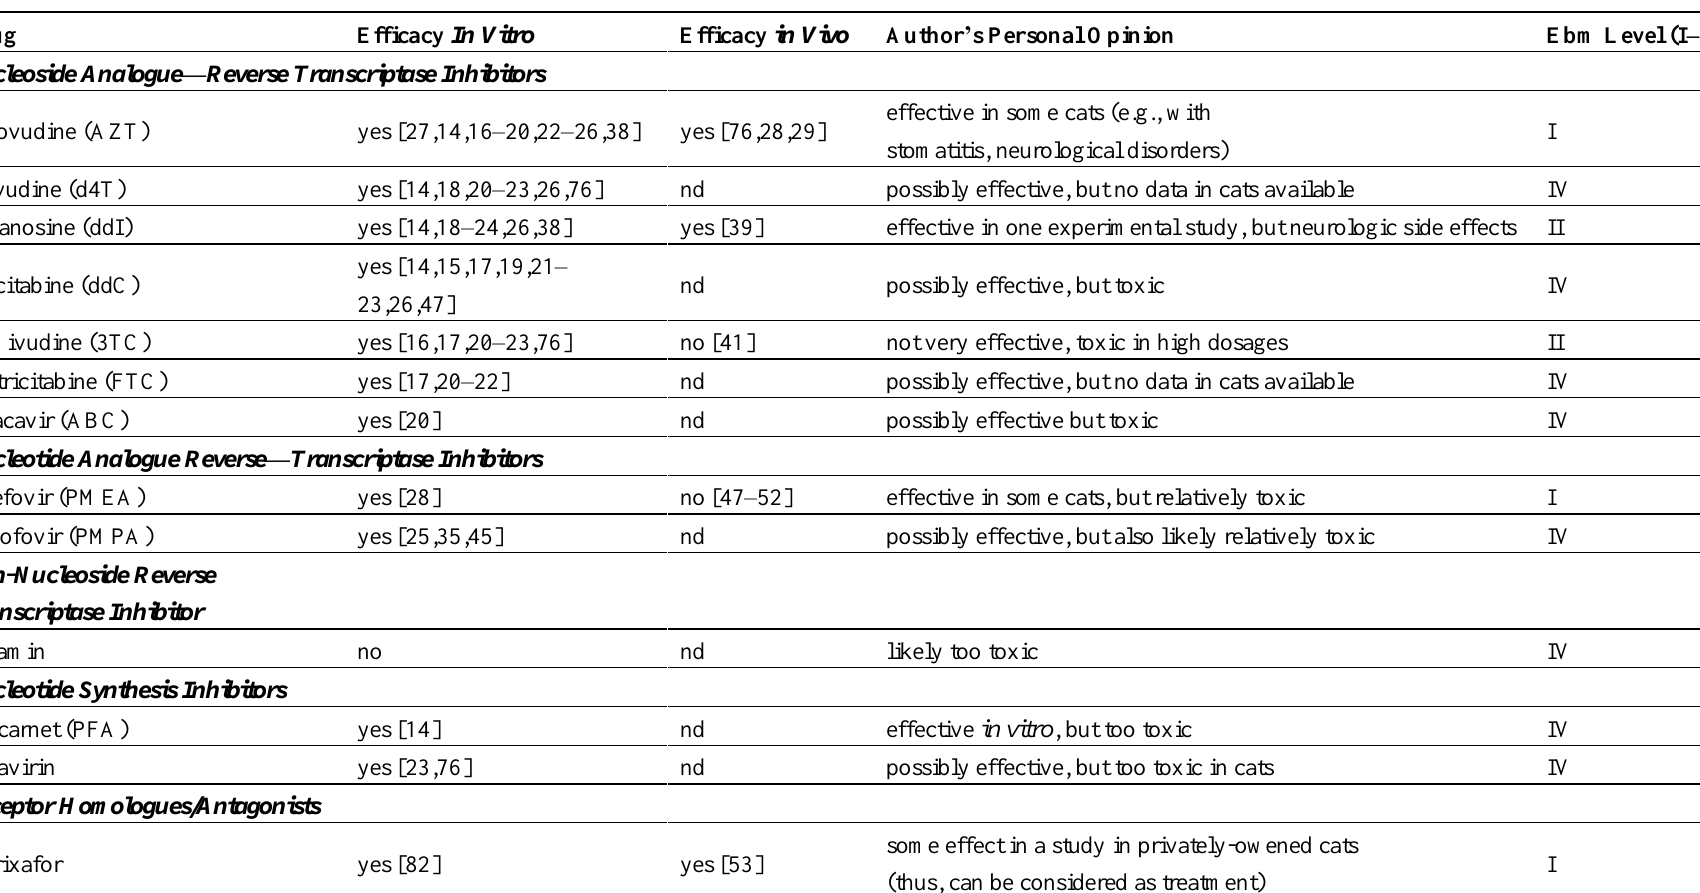
Table A1. Treatment options (antiviral drugs) for FIV-infected cats (including EBM grades for judgment of the available efficacy data; EBM grades used according to the European Advisory Board of Cat Diseases